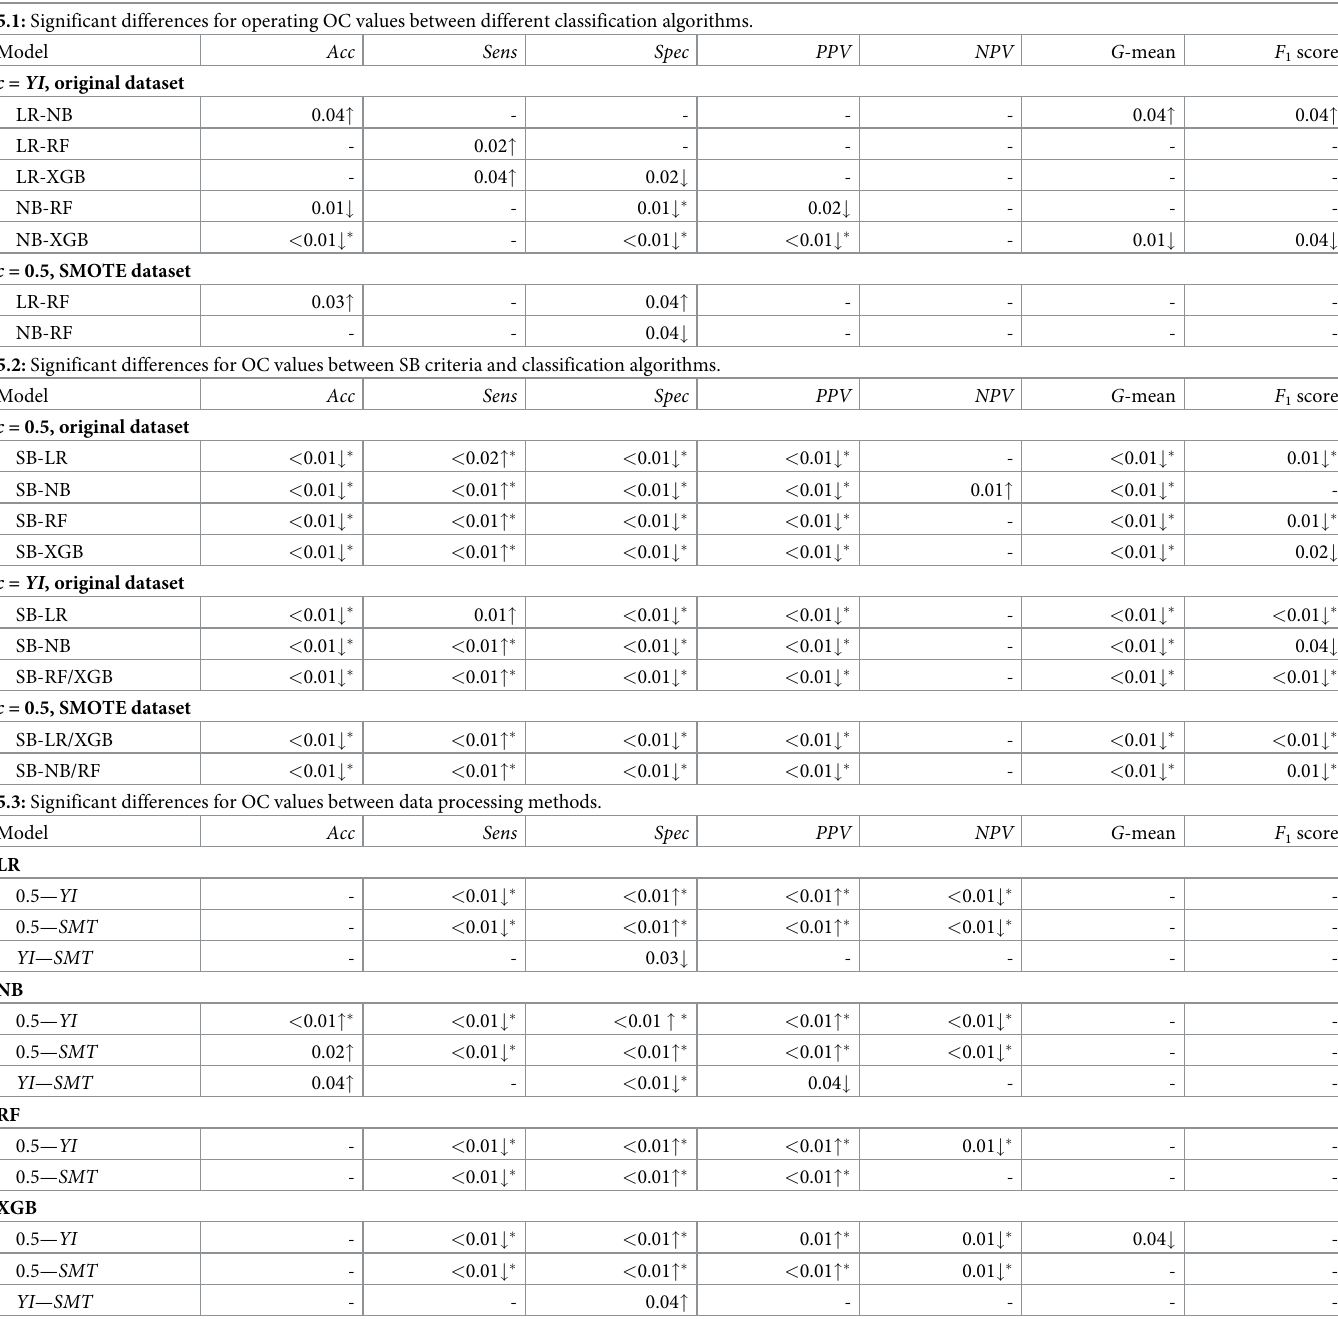
Table 5. Significant differences for operating characteristics (OC) values among several classification methods. 5.1: Significant differences for operating OC values between different classification